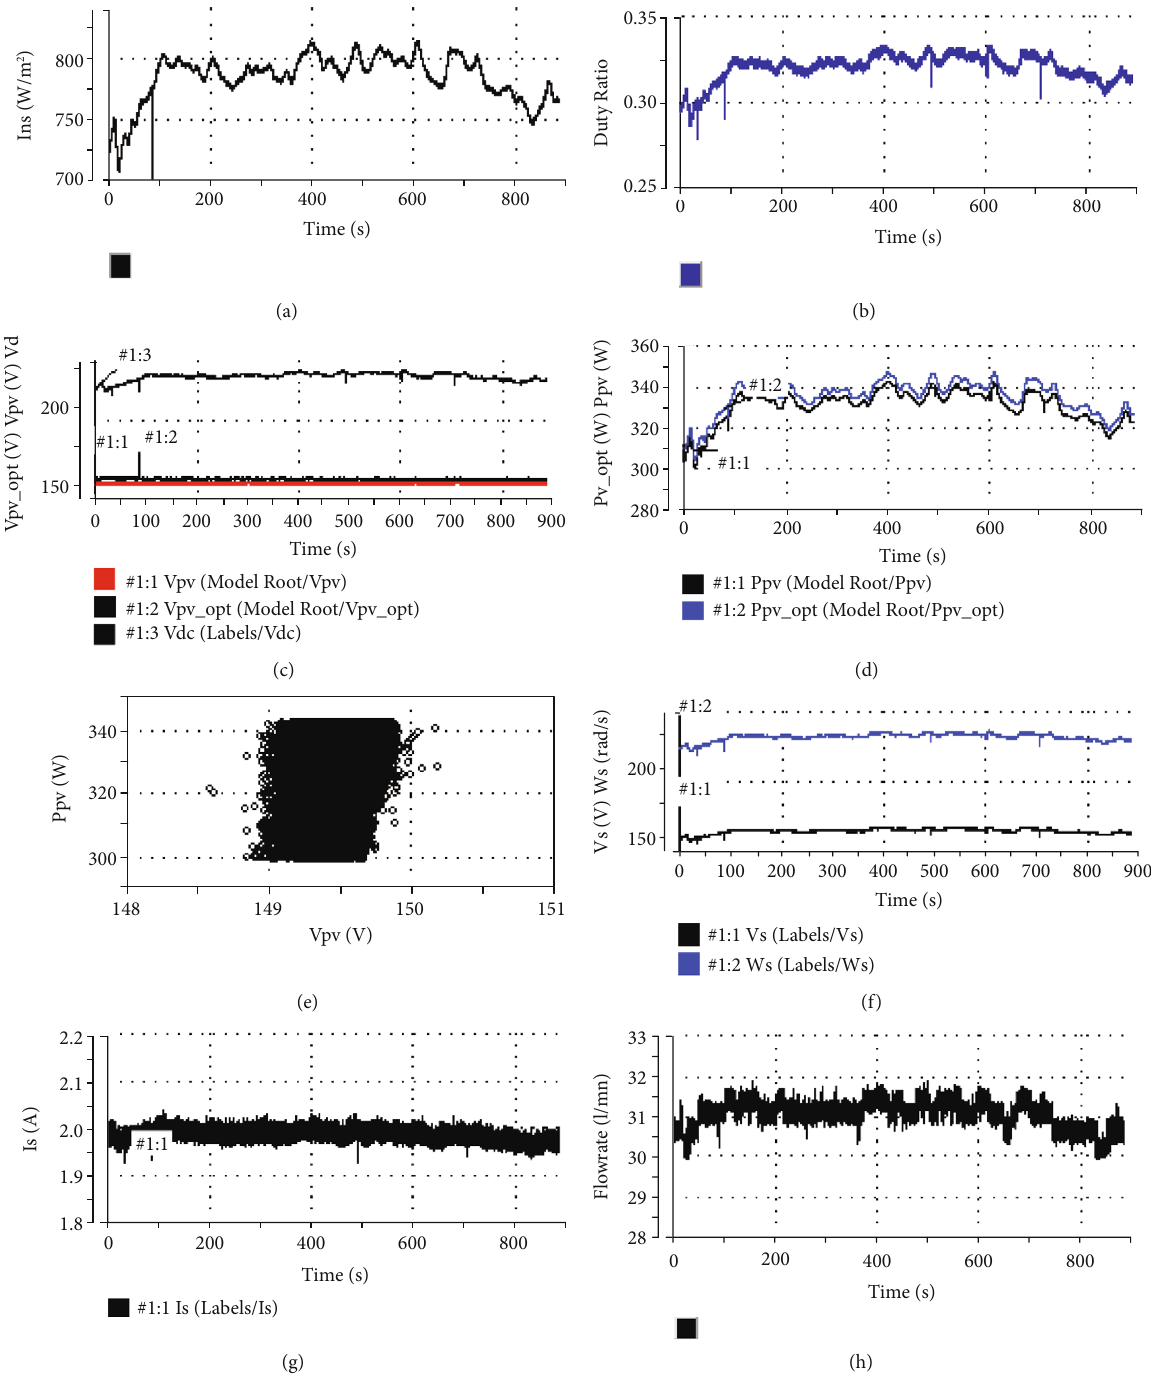
Figure 15: Experimental results of SVPWPS under constant temperature and insolation: (a) evolution of the insolation variation; (b) evolution of the duty cycle; (c) evolution of the input and output voltages; (d) evolution of PV powers; (e) a movement of MPP versus the optimum voltage; (f) stator voltage and pulsation response; (g) stator current response; (h) fl ow rate